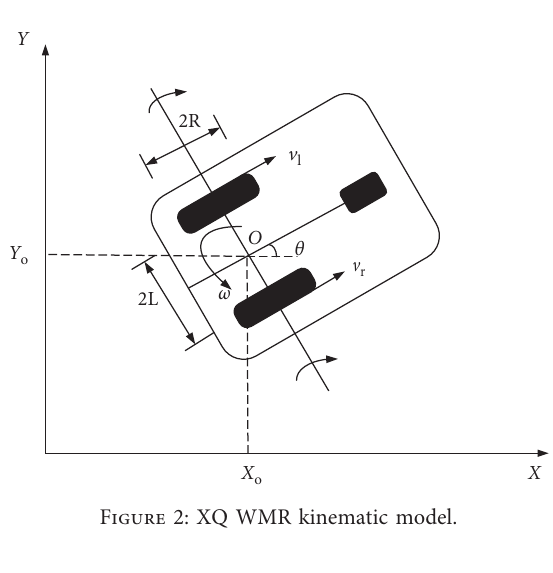
Figure 1: XQ WMR.